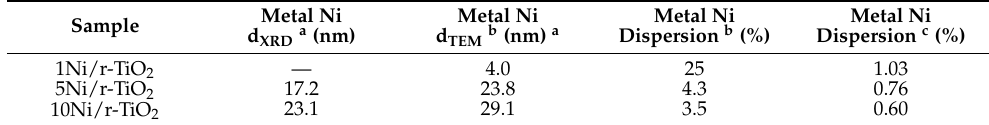
Figure 3. TEM images of 650 °C reduced ( A ) 1Ni/r-TiO 2 , ( B ) 5Ni/r-TiO 2 , and ( C ) 10Ni/r-TiO 2 cata- lysts.